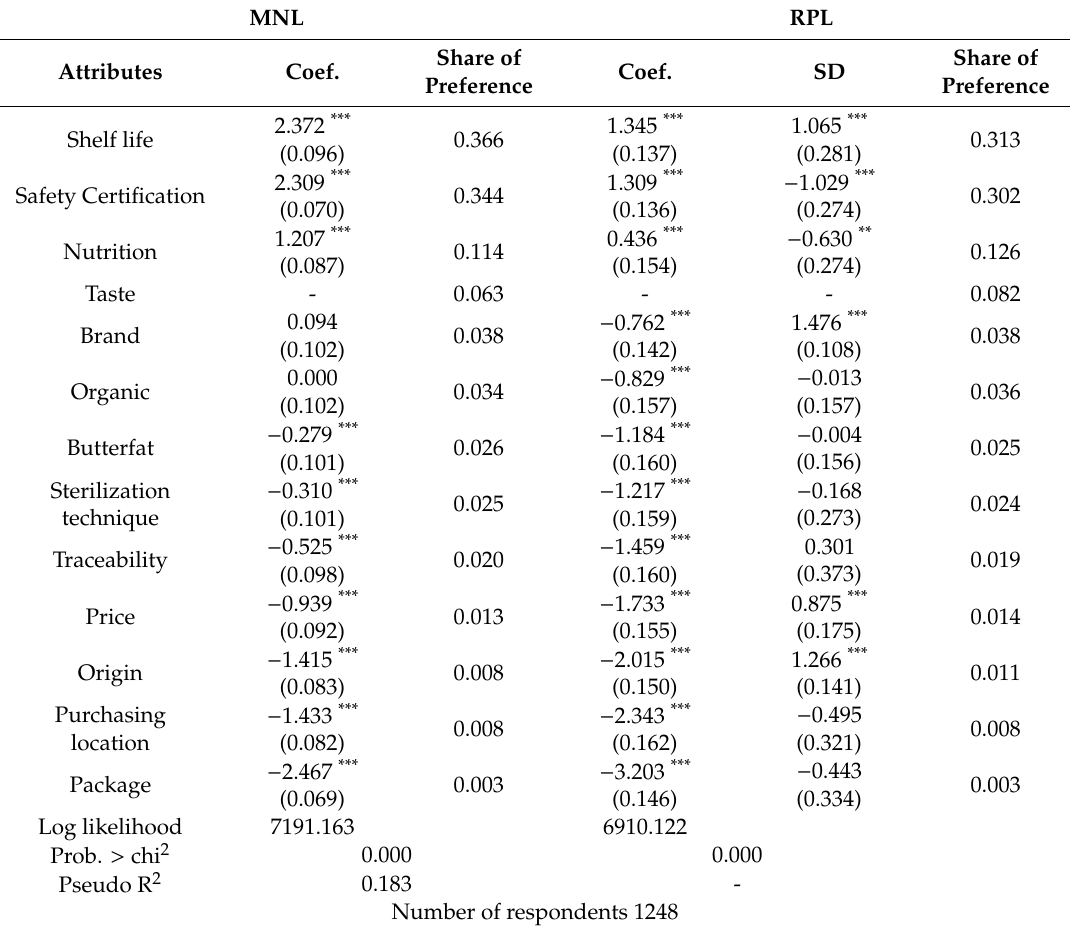
Table 4. Relative importance of